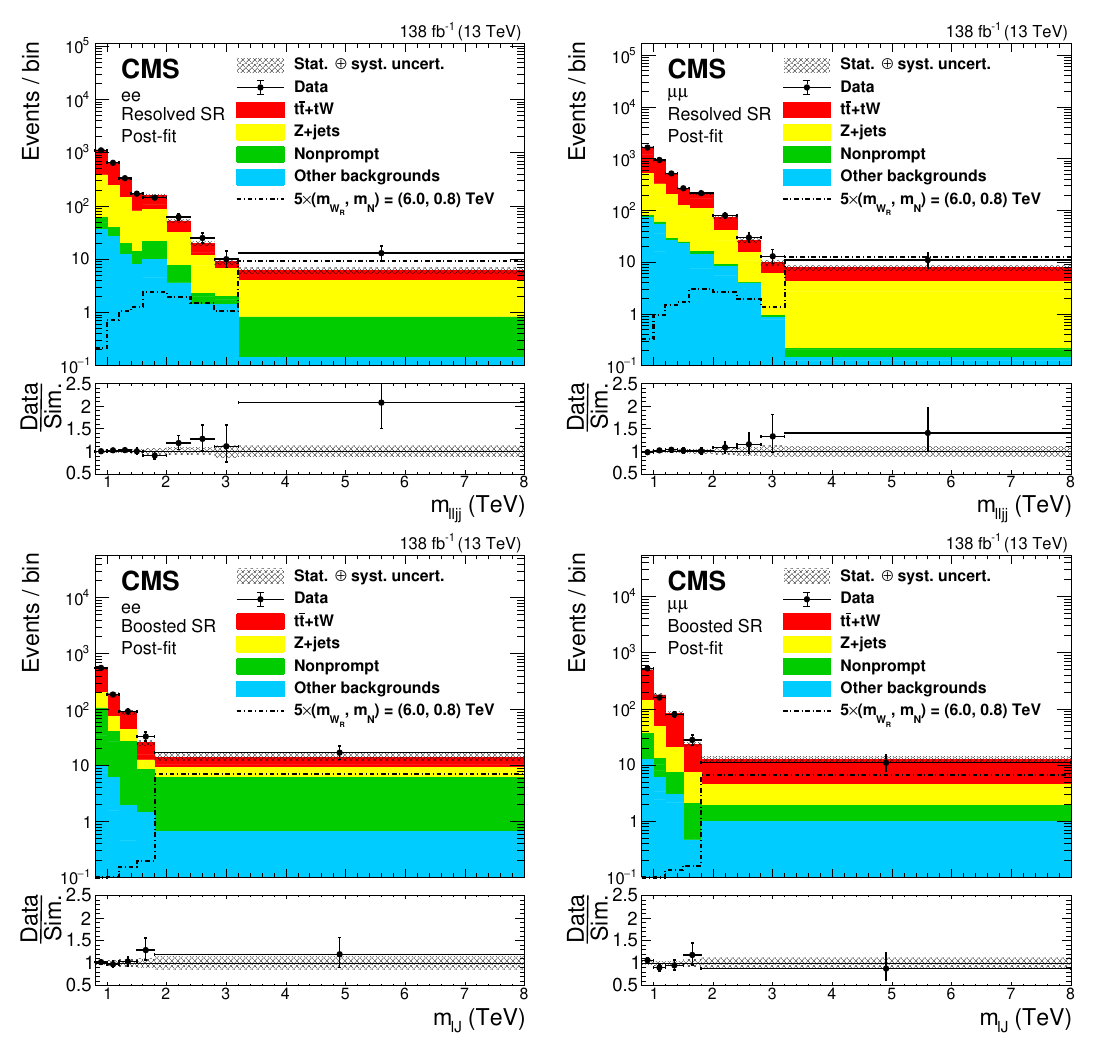
( m ) distributions in the resolved (boosted) SR are ‘‘ jj ‘ J